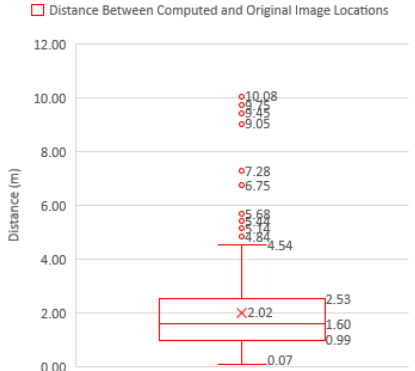
Table 2 negatively affecting the image selection results due to wrong cca values.